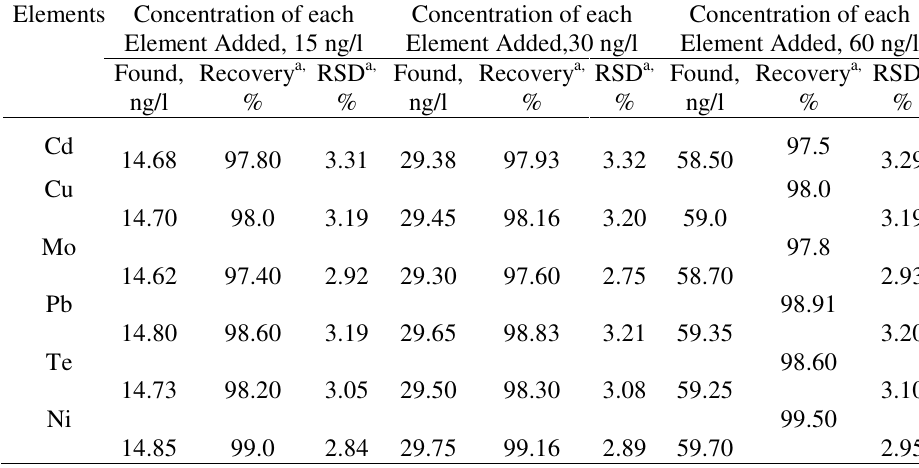
Concentration of each Element Added, 60 ng/l Recovery a, ng/l